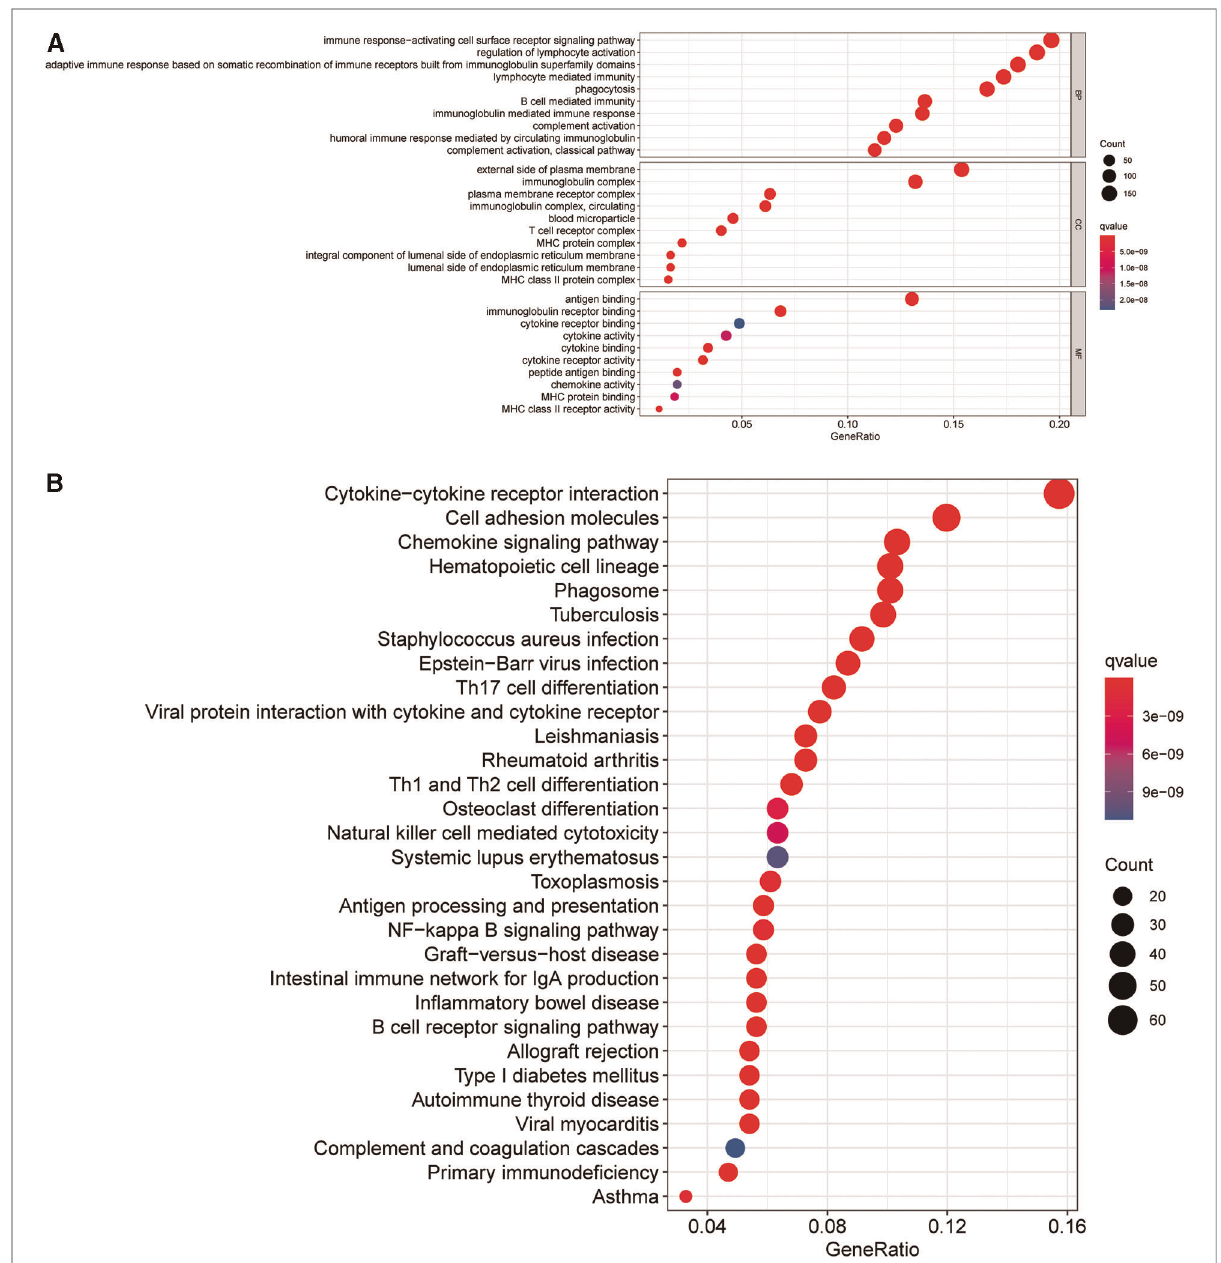
FIGURE 6 Functional analysis for the signature. ( A ) Signi fi cantly enriched biological processes in GO analysis. ( B ) Signi fi cantly enriched pathways in KEGG